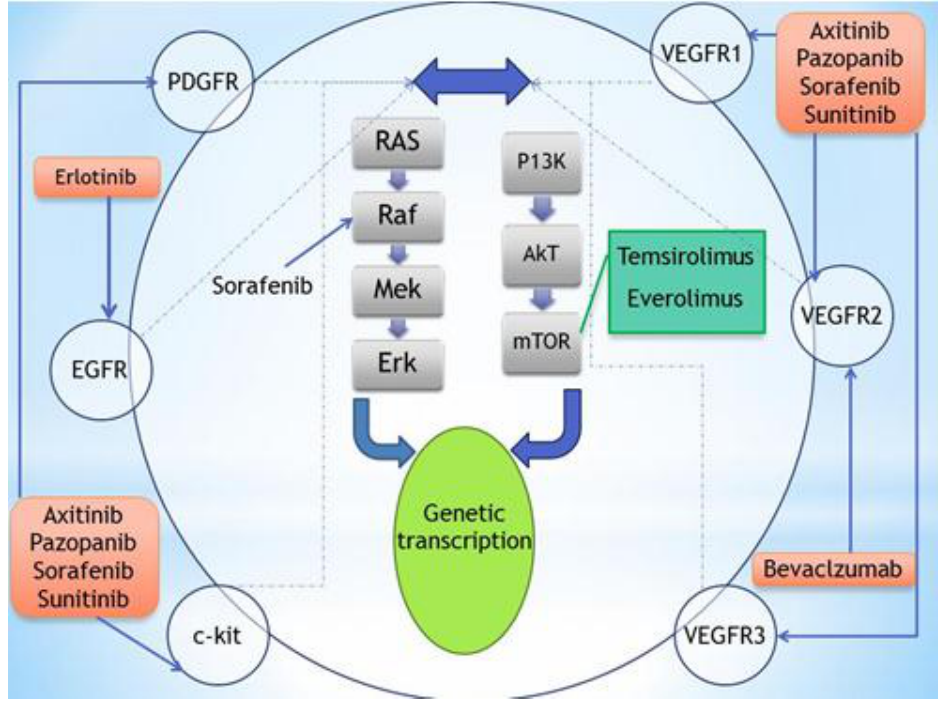
Figure 1. Targeted therapies for metastatic renal cell carcinoma and their mode of